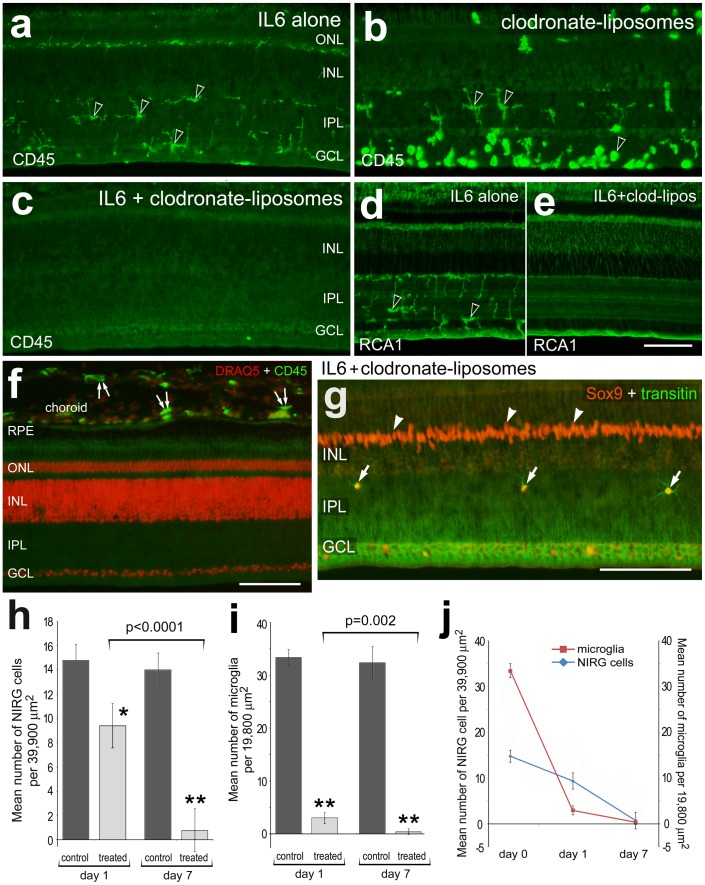
NIRG cells do not survive when the microglia have been selectively ablated by the combination of IL6 and clodronate-liposomes.The dose of clodronate-liposomes was titered-down to the minimum dose required to eliminate >90% of the microglia at 1 days after treatment. Vertical sections of the retina were labeled for CD45 (a–c), RCA1 (d and e), CD45 and DRAQ5 (f), and transitin and Sox9 (g). Retinas were obtained from eyes one day after treatment with IL6 alone (a and d), clodronate liposomes alone (b) or IL6 with clodronate liposomes (c and e–g). Arrows indicate NIRG cells in the IPL, hollow arrow-heads indicate the somata of microglia, arrow-heads indicate the nuclei of Müller glia, and small double-arrows indicate monocytes in the choroid. The scale bar (50 µm) in panel f applies to a–c and f, the bar in e applies to d and e, and the bar in g applies to g alone. The histograms in panels h and i, and the plot in j, illustrate the mean (±SD) number of microglia in the retina (i and j) or NIRG cells (h and j) in the IPL and INL at 1 and 7 days after treatment with IL6 alone (control) and IL6 with clodronate-liposomes. Significance of difference was determined by using a one-way ANOVA (p<0.0001). Significance of difference between control and treated groups (*p<0.001, **p<0.0001), and between treatment time-points (brackets and p-values) was determined by using a post-hoc two-tailed Student’s t-test. Abbreviations: RPE – retinal pigmented epithelium, ONL – outer nuclear layer, INL – inner nuclear layer, IPL – inner plexiform layer, GCL – ganglion cell layer.